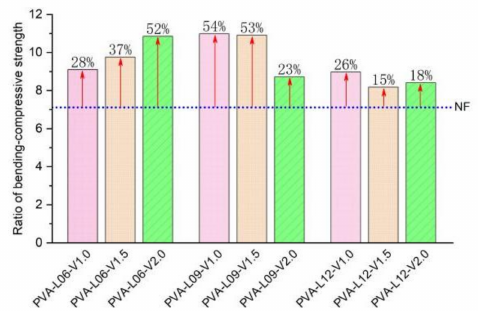
Figure 14. Relation between the growth rate of the bending-compressive strength ratio and L/D